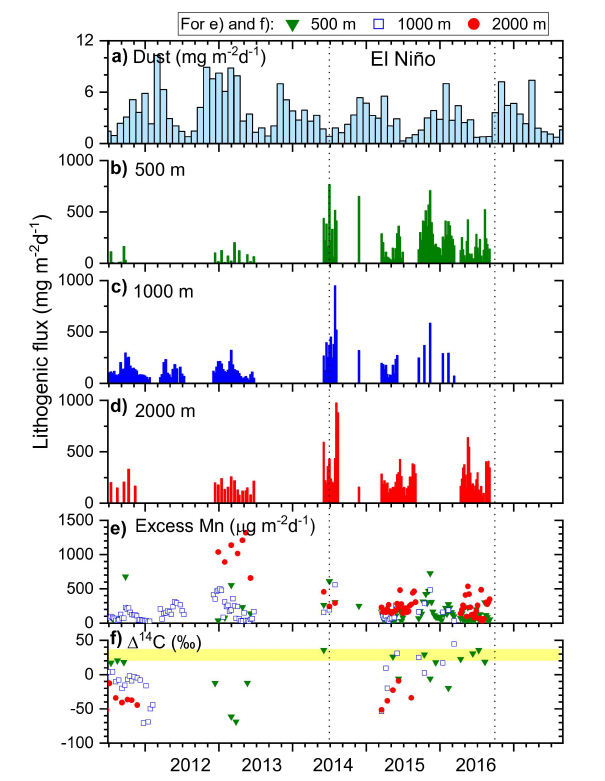
FIGURE 4 | (a) Dust deposition to the sea surface based on a MERRA 2 model; (b–d) lithogenic material flux at 500 m, 1000 m, and 2000 m, respectively; (e) excess Mn flux at the three sampling depths; and (f) (cid:49) 14 C ( ) values. To facilitate comparison, the (cid:49) 14 C results at 1000 m and 2000 m of Station EC1 in 2011–2012 are also included (Kim et al., 2017). Yellow (cid:104) horizontal bar indicates the range of the (cid:49) 14 C values of dissolved inorganic carbon (DIC) in the surface waters at nearby sites (30 ± 12 et al.,